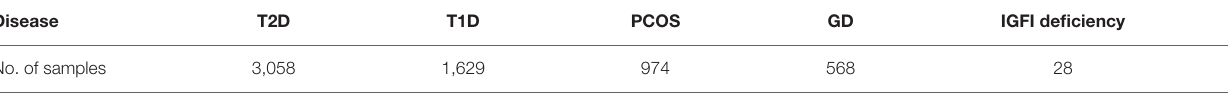
TABLE 1 | Number of curated disease genes. Disease